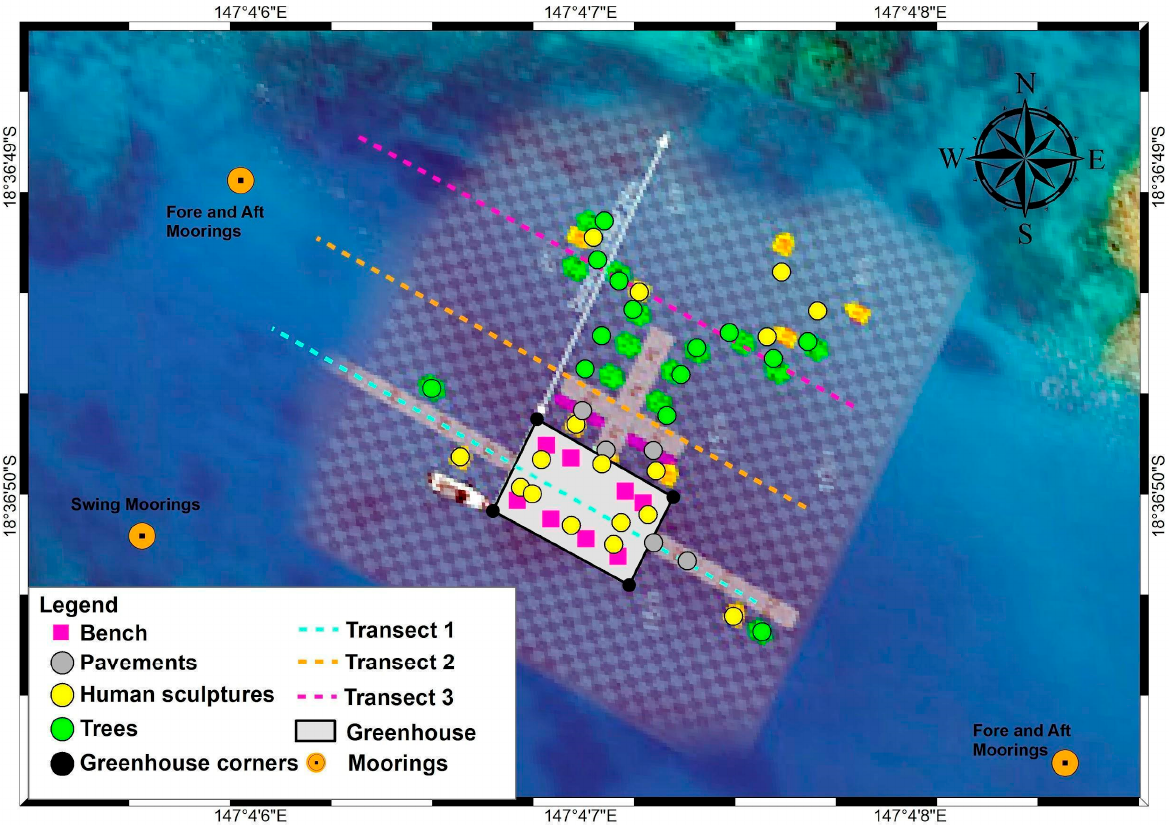
Figure 3. Location of underwater sculptures and 3 × 50 m transects at Coral Greenhouse site.